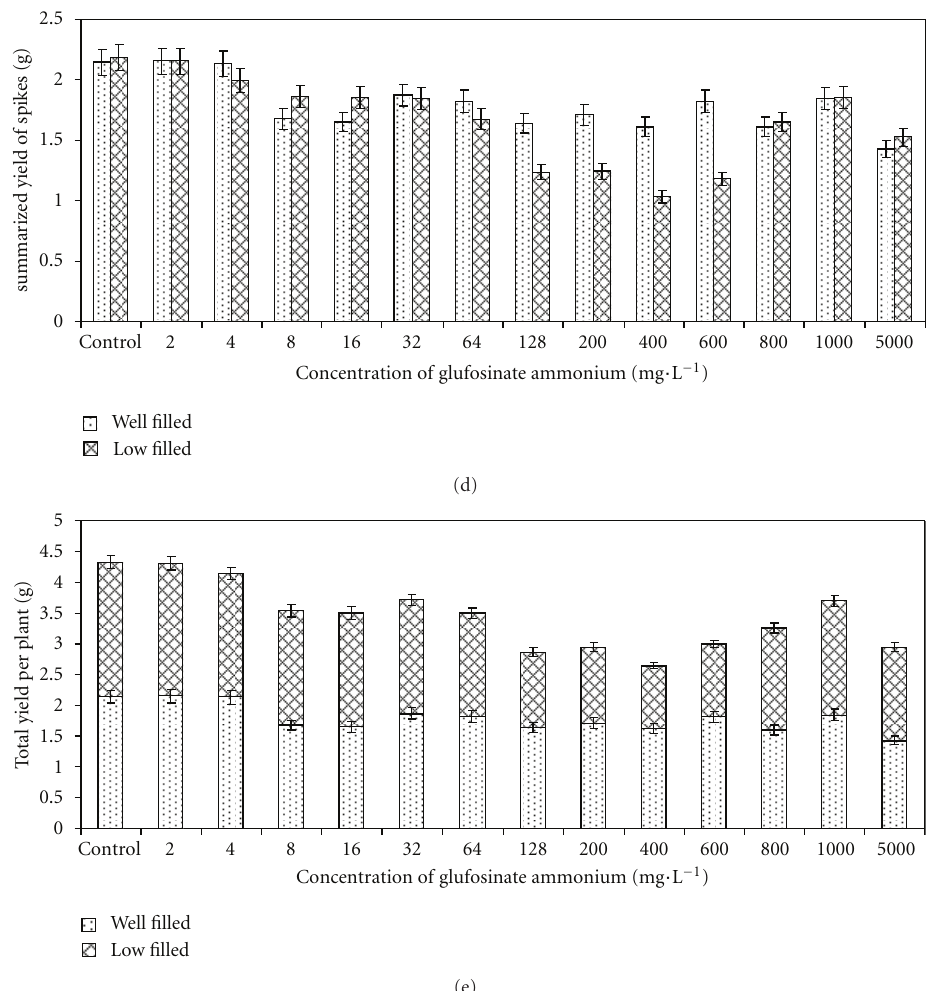
Figure 6: E ff ect of di ff erent concentrations of the herbicide glufosinate ammonium on the number of spikes (a), number of grains per spike (b), thousand kernel weight (c), summarized yield of spikes (d), and total yield per plant (e) of the transgenic wheat line “T-124.” Values are equal to the average of the eight repeat